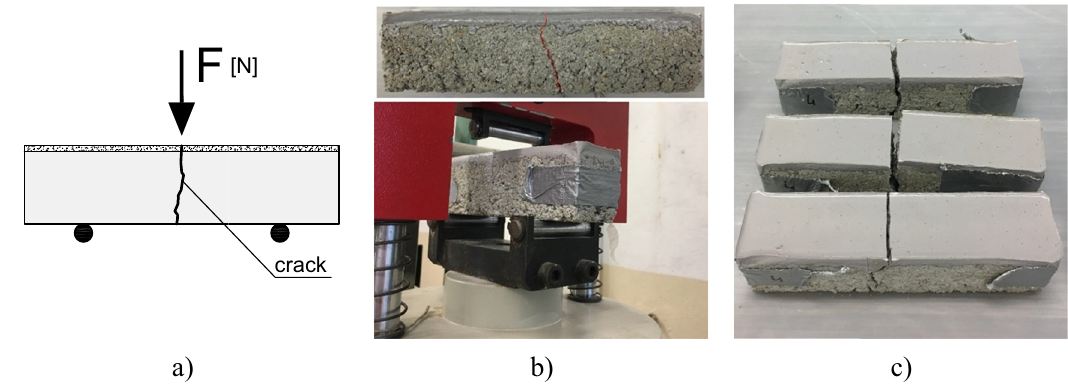
Figure 5: The fl exural tensile strength test: ( a ) scheme of the test; ( b ) view of a specimen during the test with crack propagation highlighted with the red line; ( c ) destroyed specimens.